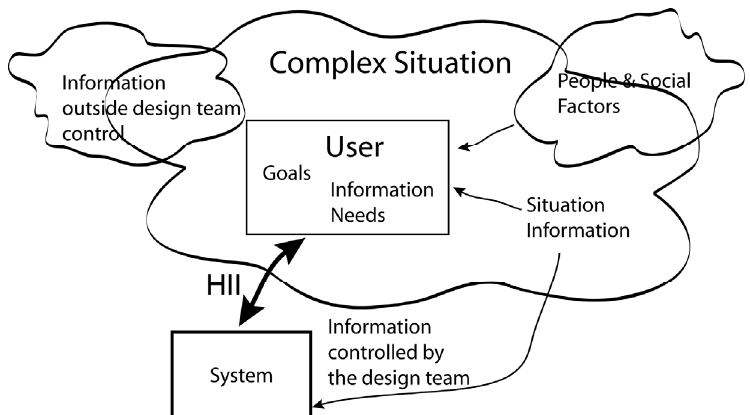
Figure 1. Complex situation with information both inside and outside of a design team’s control. Human–information interaction (HII) only directly applies to the information a design team